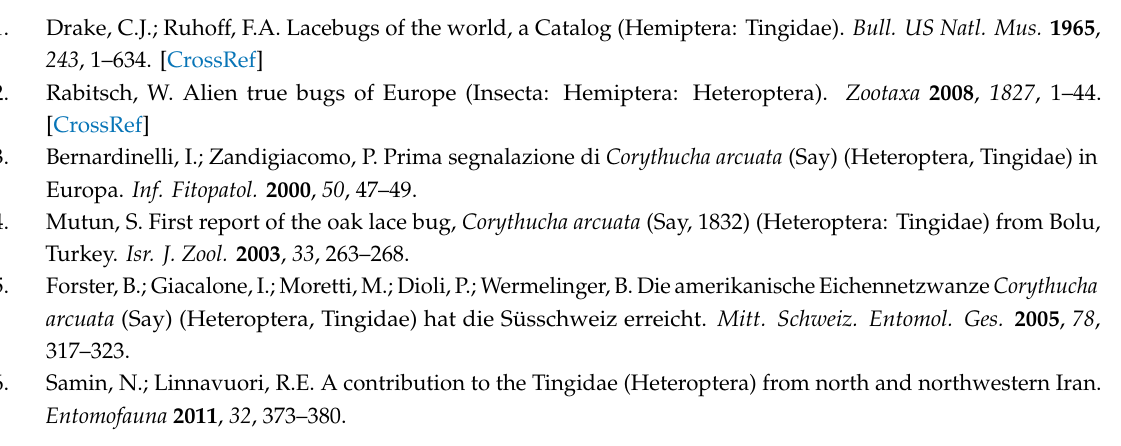
Table S1: Genbank accession numbers of sequences used in the phylogenetic